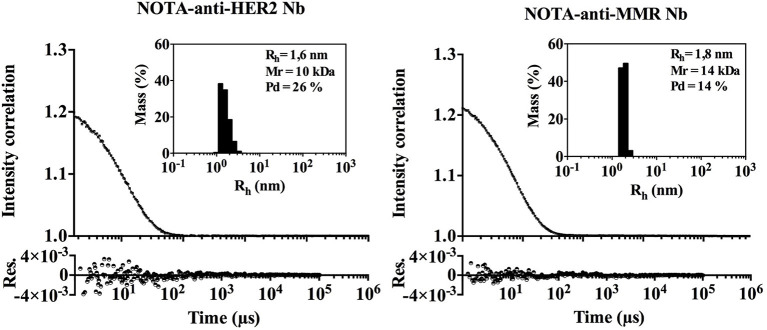
DLS measurement of both Nanobodies. Dynamic Light Scattering (DLS). Black dots and line represent the experimental data and fit, respectively. The residuals (Res.) are shown. The percentage of mass as a function of the Rh distribution is given in the inset.